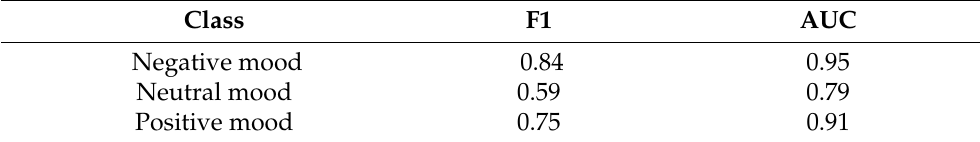
Table 1. F1 and AUC measures for the use of multimodal features and logistic